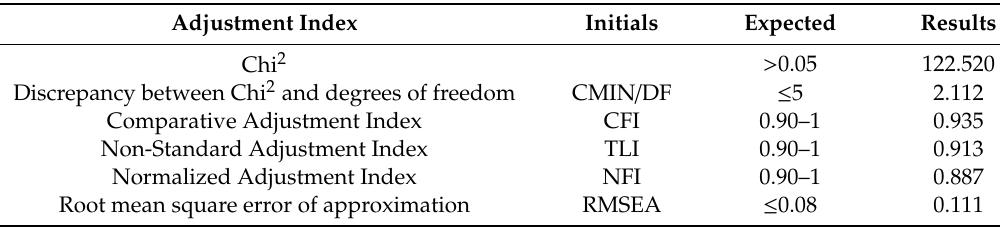
Table 4. Results SEM / AMOS tests for the co ff ee governance